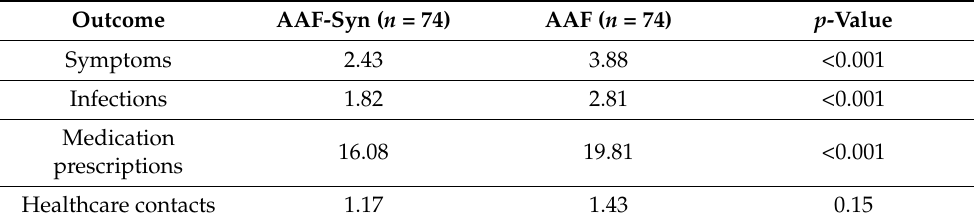
Table 3. Rate per person-year of all-cause a symptoms, infections, medications and healthcare contacts with AAF-Syn vs.